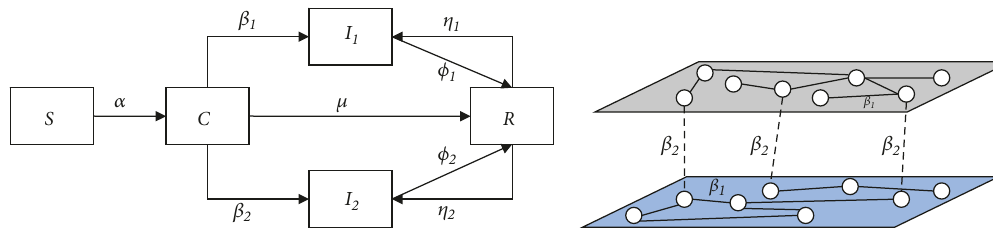
(a) Layer process of investor risk contagion on bilayer-coupled networks in the stock market Figure 12: Investor risk contagion mechanism on bilayer-coupled networks in the stock